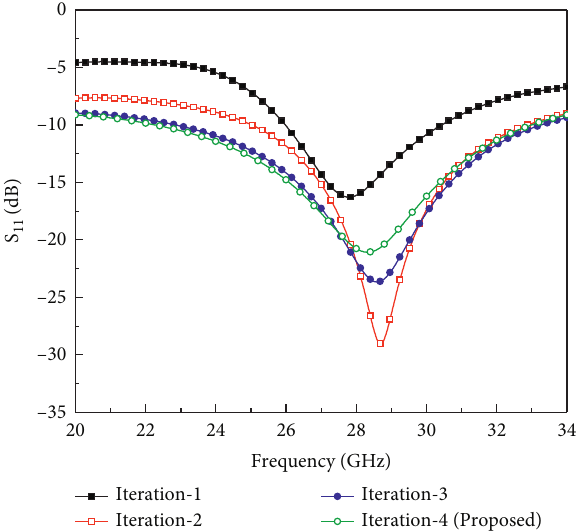
Figure 3: Simulated S